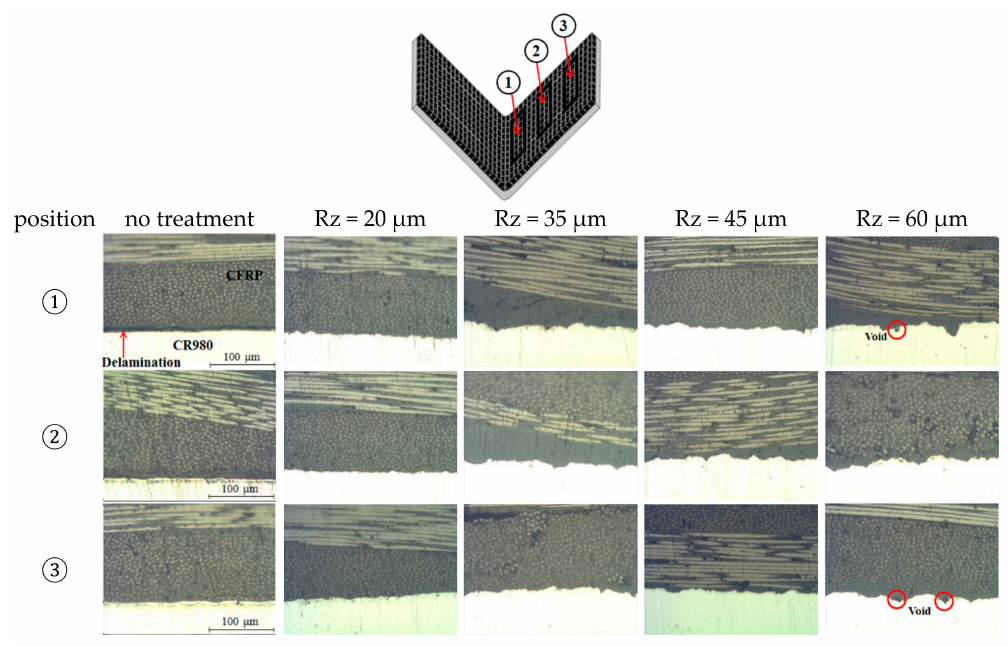
Figure 14. Microstructures (section view) at different positions of CFRP/CR980 hybrid composites conducted by a V-bending